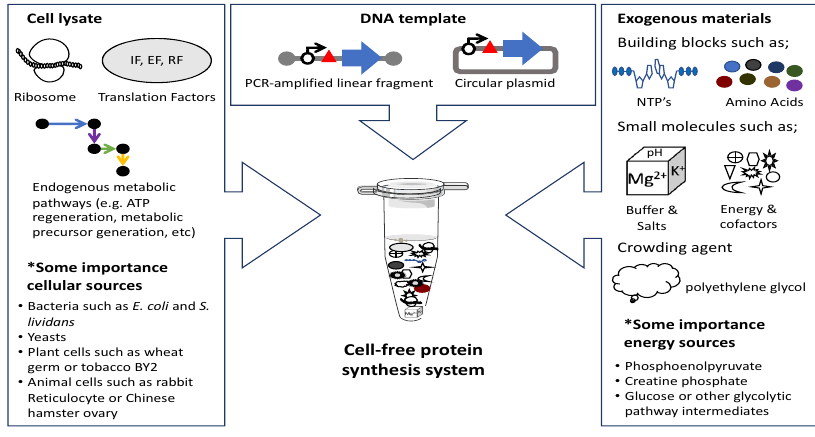
Figure 2. Typical cell-free protein synthesis system showing major